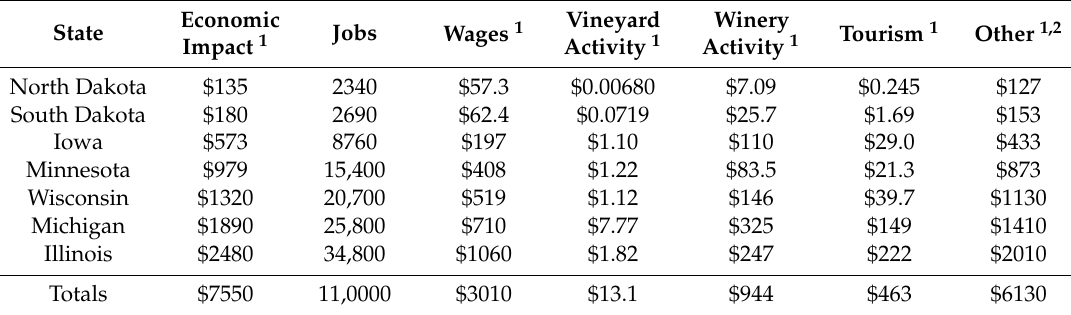
Table 1. Economic impact of the U.S. Midwest (cold climate) wine industry [1].